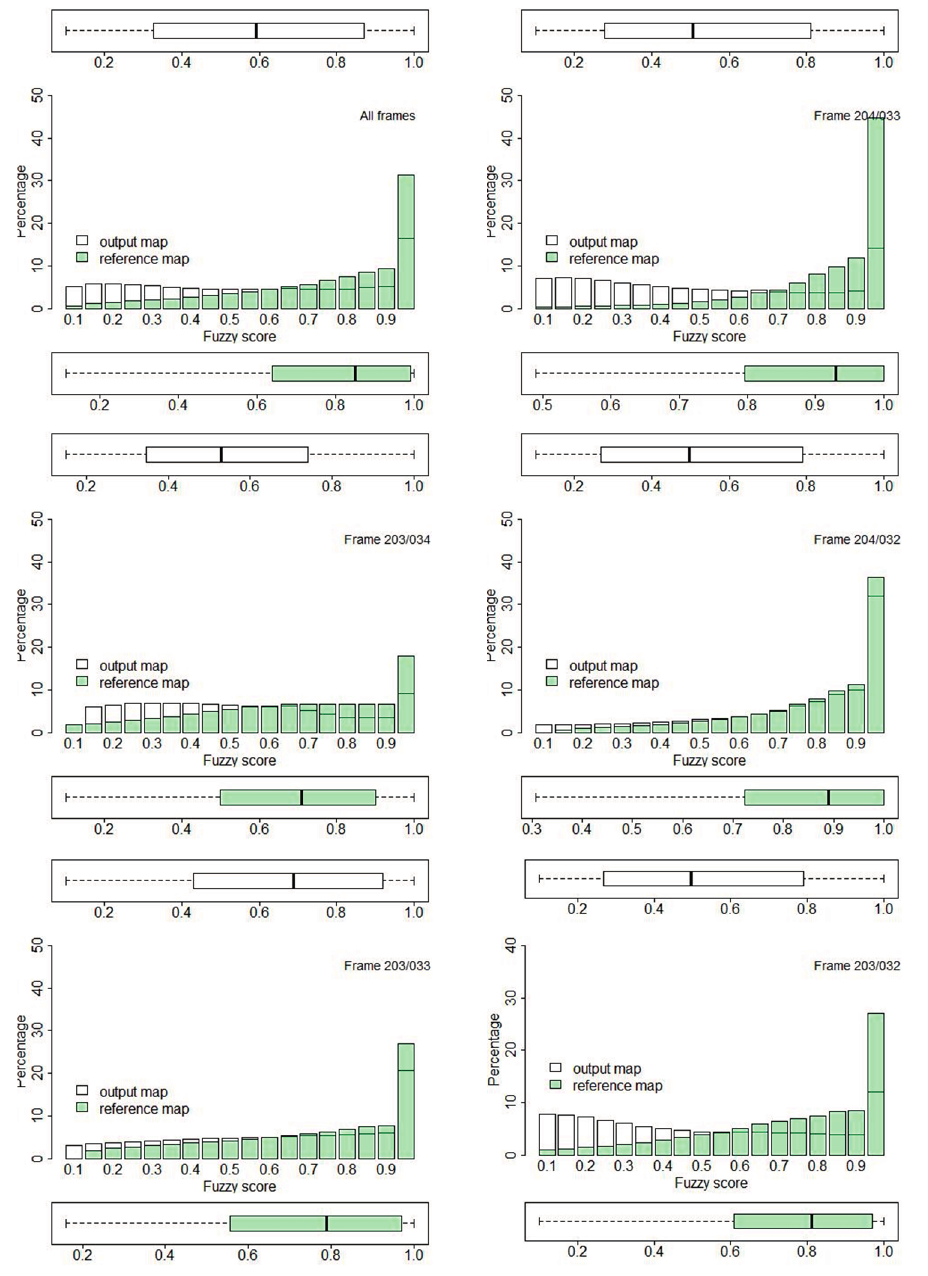
Figure 8. In each panel: the box plot and the histogram (expressed as percentages) of the fuzzy score in the map output from the fuzzy algorithm (white) and over real burned areas as derived from the reference map (green) for each TM frame and the entire study area (“all